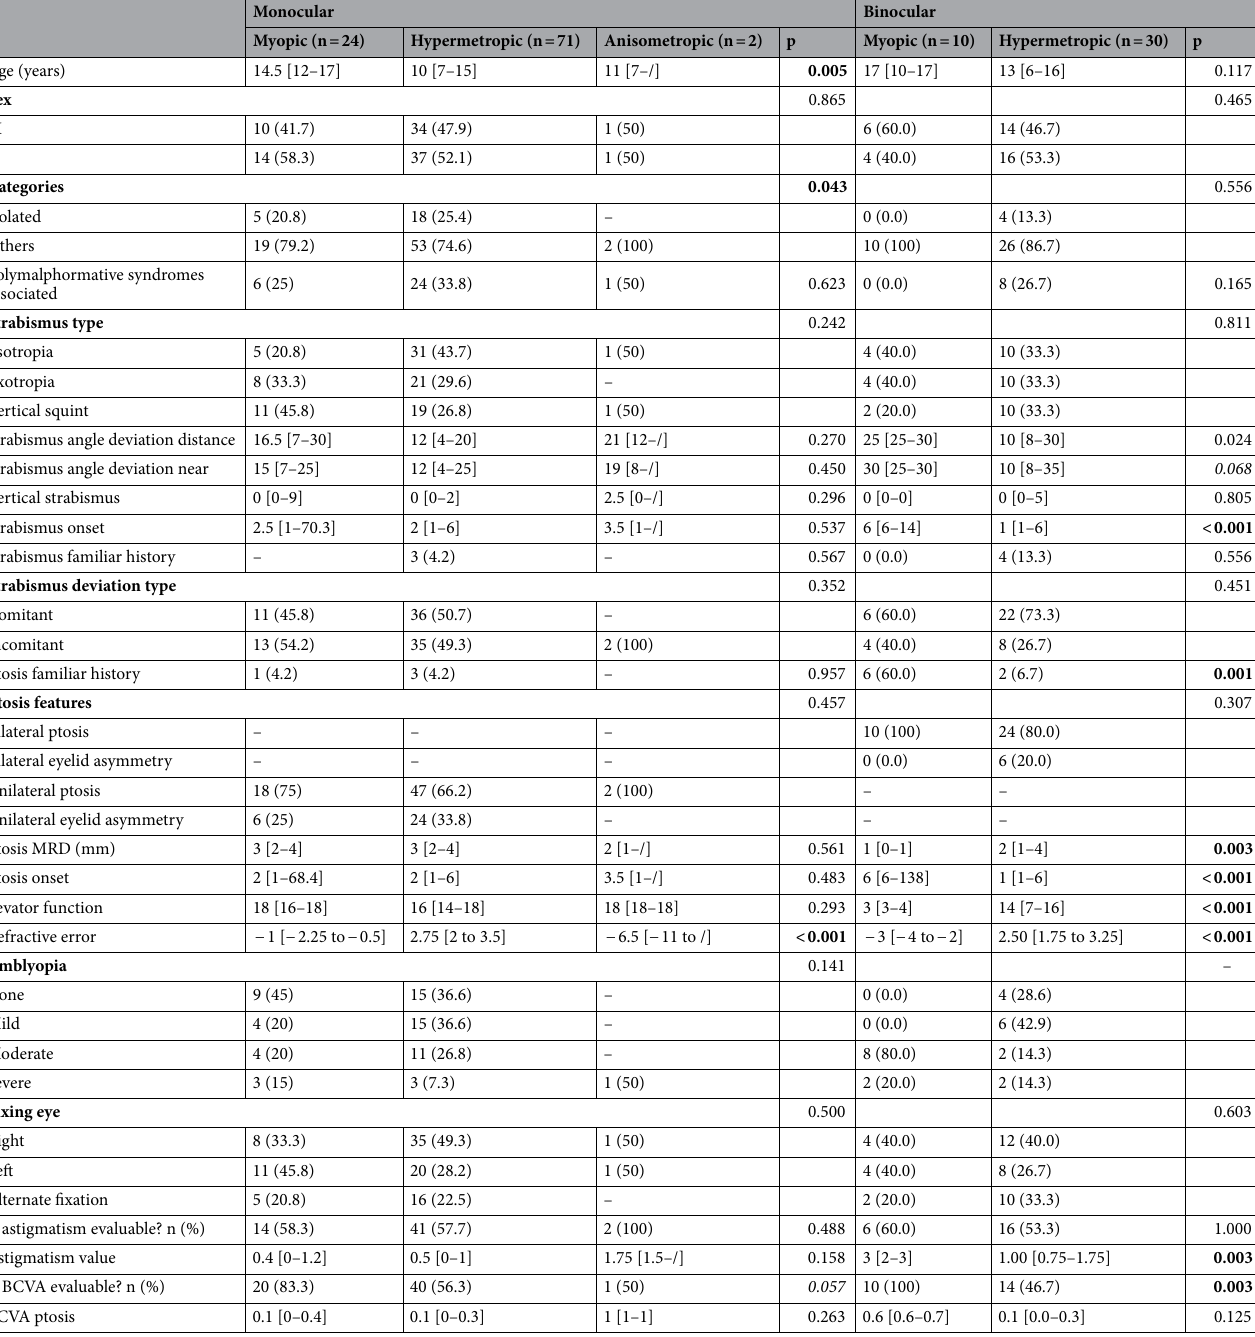
Table 4. Association between type of refractive error and general and clinical characteristics in the study cohort, according to patients’ subgroups (n = 137). M male, F female, MRD margin reflex distance, BCVA